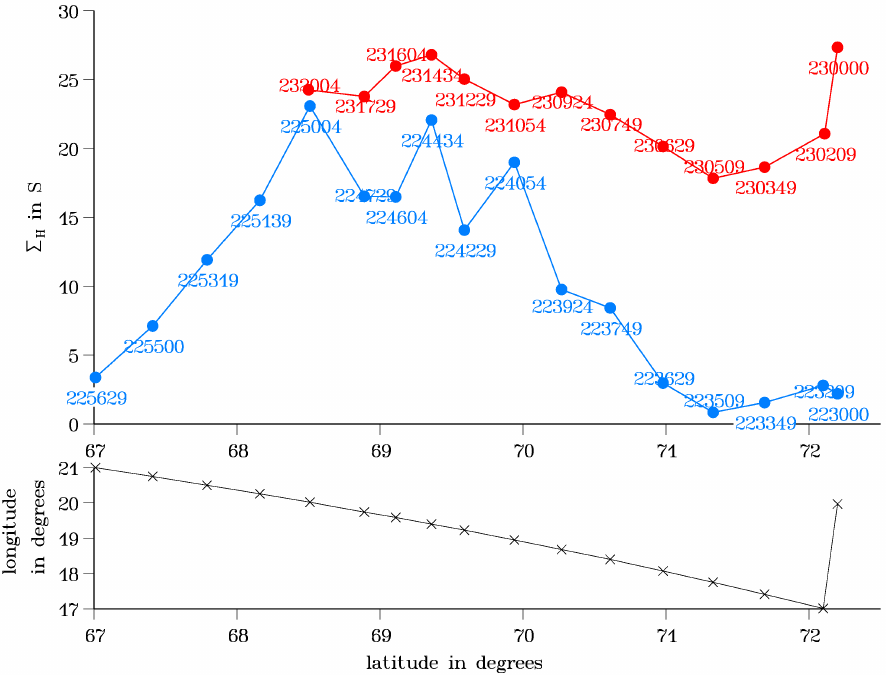
Fig. 10. Upper panel: EISCAT height-integrated Hall conductance values (integrated along the radar beam, which is not necessarily field- aligned), in S, for two consecutive scans from north to south. Blue: Scan mostly before substorm activation at 22:50 UT; red: Scan after substrom activation. Numbers at the dots (measurement points) mark the times of the observations. Lower panel: Latitude and longitude of the radar beam at 114km for each measurement